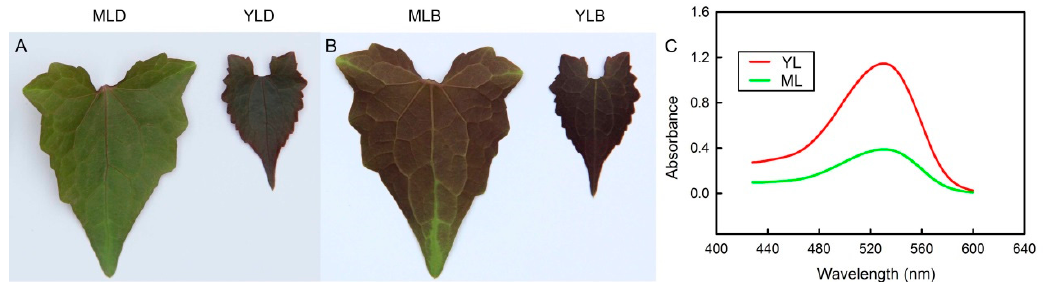
Figure 1. The morphology characteristics of leaves. ( A ) Adaxial surfaces of the mature leaves (MLD) and young leaves (YLD). ( B ) Abaxial surfaces of the mature leaves (MLB) and young leaves (YLB). ( C ) The absorbance of anthocyanin from mature leaves (ML) and young leaves (YL) (n = 5).